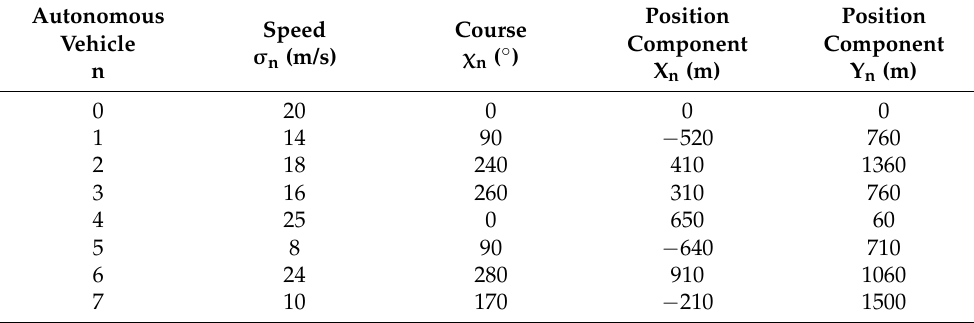
Table 2. Data of the autonomous vehicles in multidirectional traffic.